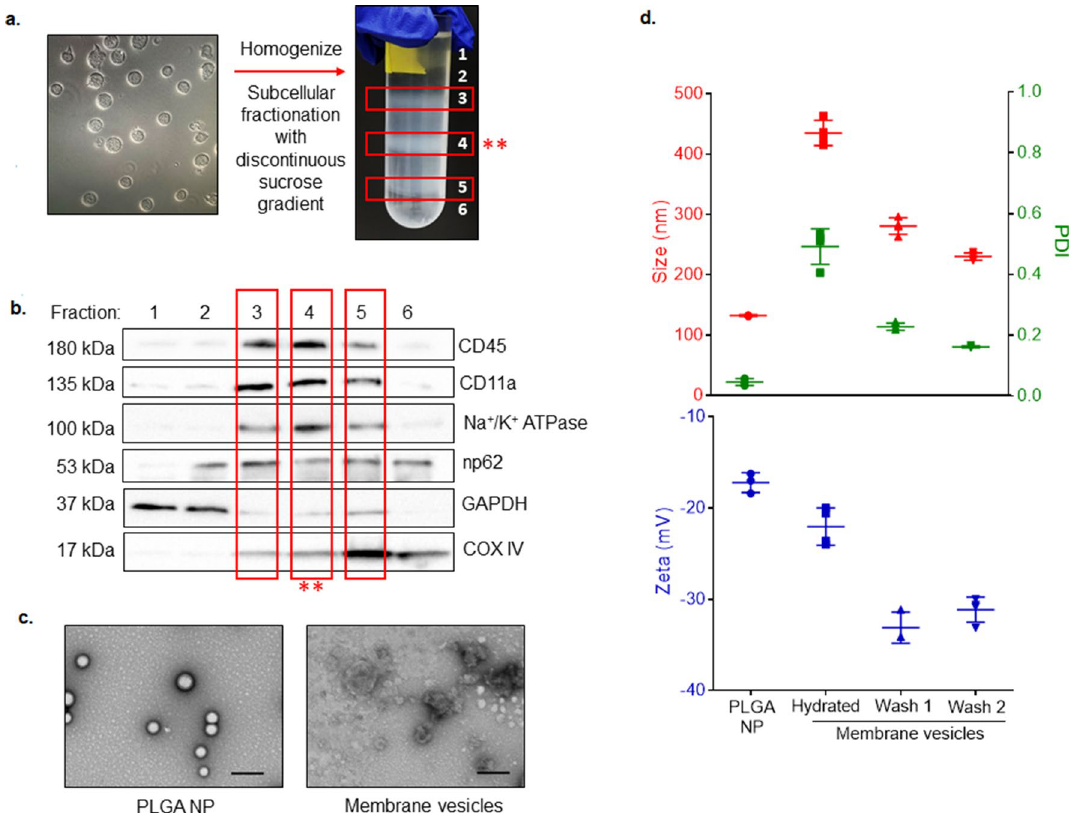
Figure 1. Schematic of membrane vesicle and PLGA nanoparticle (NP) preparation. ( a ) Images of Jurkat T cells (scale bar: 100 µm) and of cell homogenate separated into three lipid-rich subcellular fractions after density gradient centrifugation. The fraction from the 30–40% interface (red asterisks) was used for downstream experiments. ( b ) Western immunoblot demonstrating the protein profile of six collected subcellular fractions. Antibodies to plasma membrane (CD45, CD11a, Na + /K + ATPase), nuclear membrane (nucleoporin 62 (np62)), mitochondrial membrane (cytochrome C oxidase subunit 4 (COXIV)), and cytosolic GAPDH were used. ( c ) Transmission electron microscopy images depicting morphology of PLGA NP cores and rehydrated membrane vesicles. Scale bar: 200 nm. ( d ) Size (nm, red), polydispersity index (PDI, green), and zeta potential (mV, blue) of PLGA NPs and of membrane vesicles at each stage of processing. Data are the mean ± SD, n = 3–4 separate